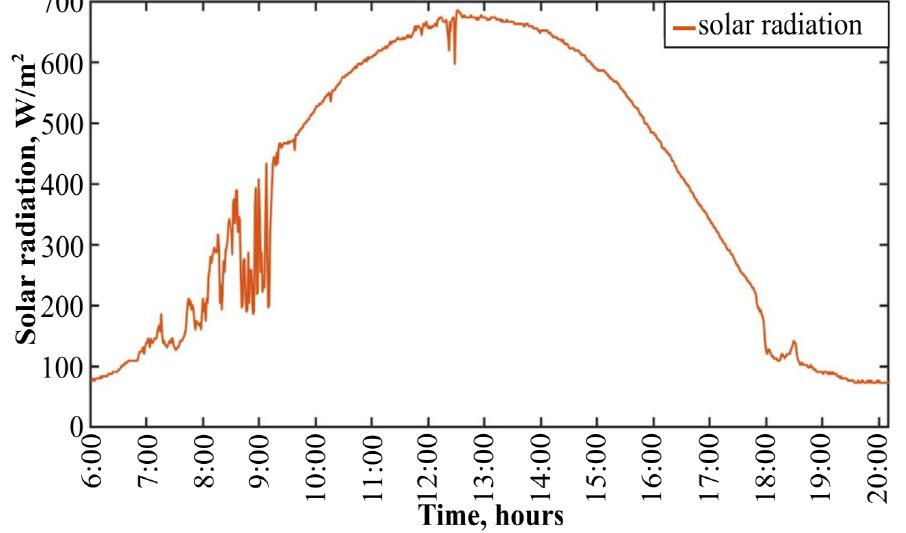
Figure 9. Experimentally measured solar radiation during the day.